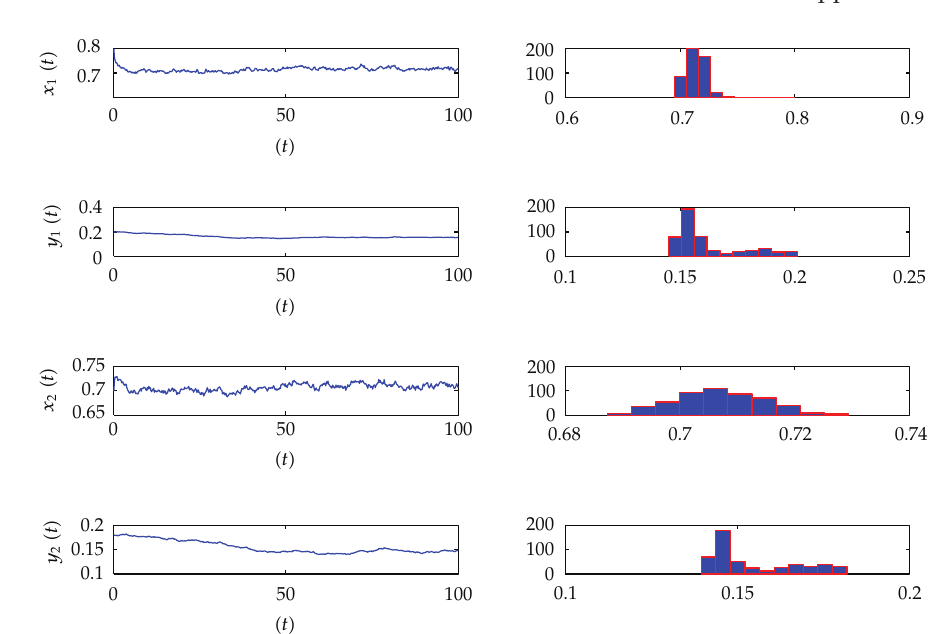
Figure 1: The solution of stochastic system (cid:2) 5.1 (cid:3) with small white noise and its histogram: σ 11 (cid:5) σ 12 (cid:5) σ 21 (cid:5) σ 22 (cid:5) 0 . 01.